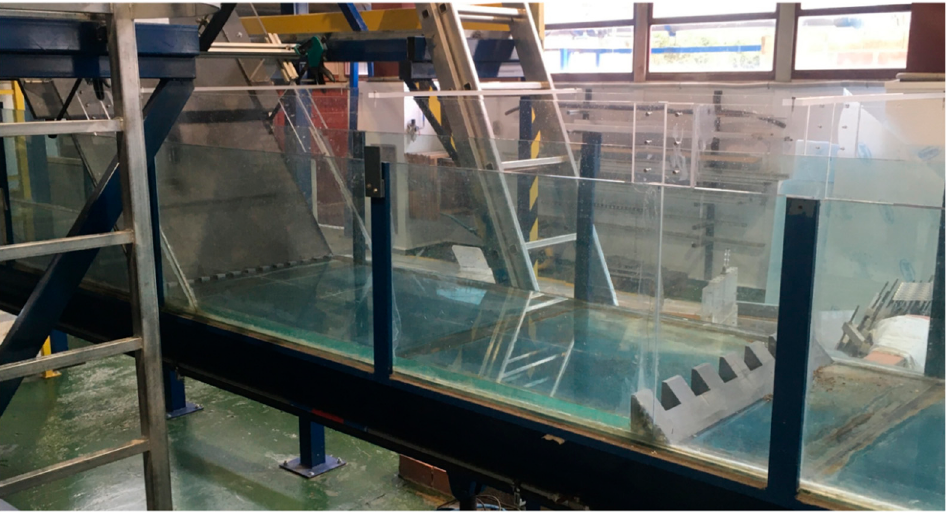
Figure 2. Physical model of the typified USBR II stilling basin built at the UPV Hydraulics Laboratory (Valencia, Spain).